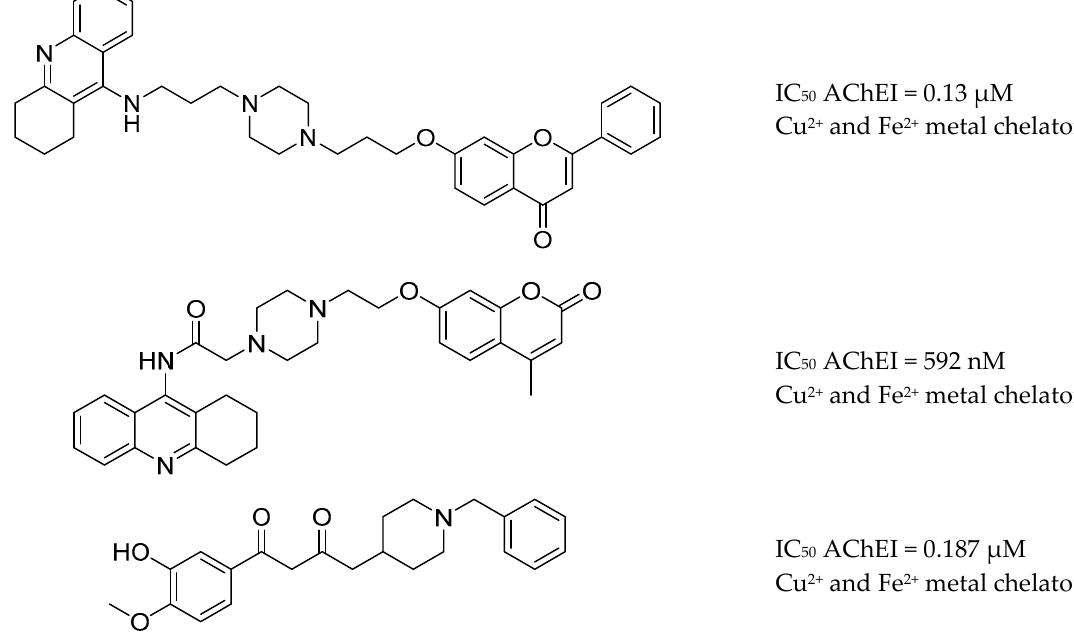
Figure 14. Hybrids of tacrine-flavone and donepezil-curcumin from [169–171].